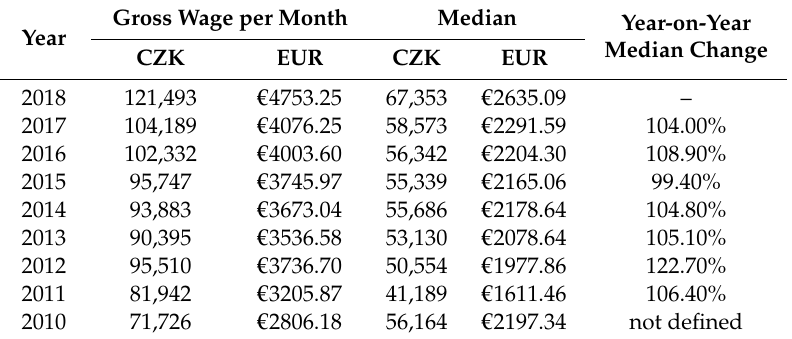
Table 4. Results of gross wage and median wage in the Czech